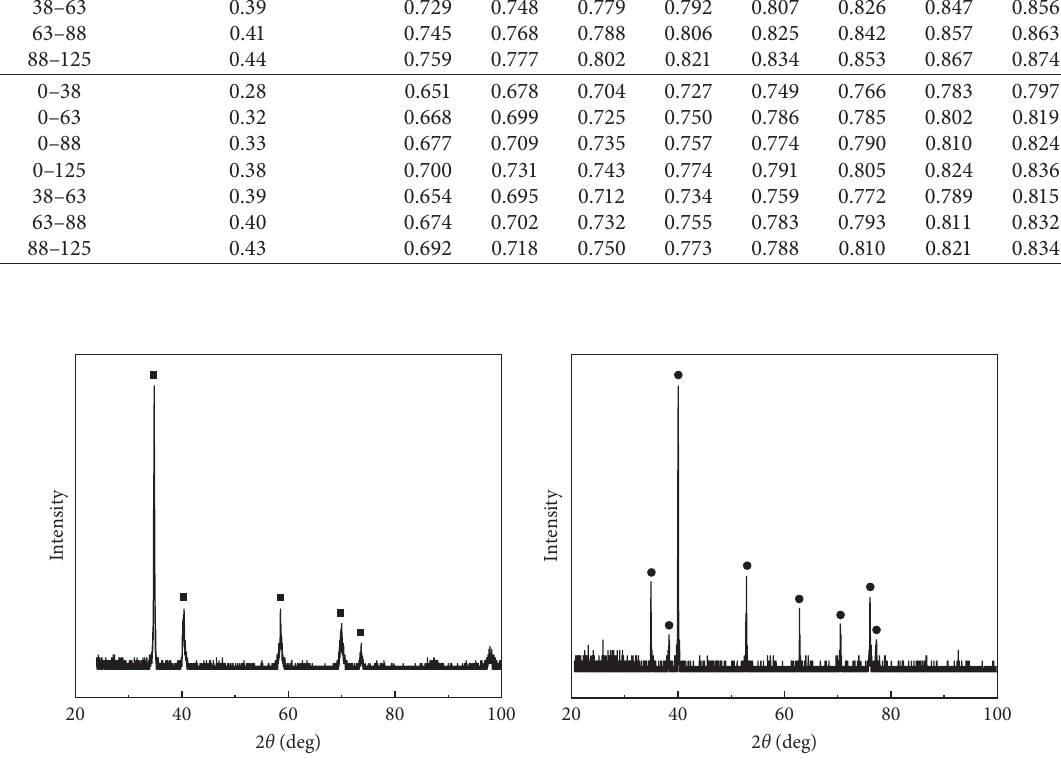
Figure 3: XRD patterns of initial powders: (a) TiH